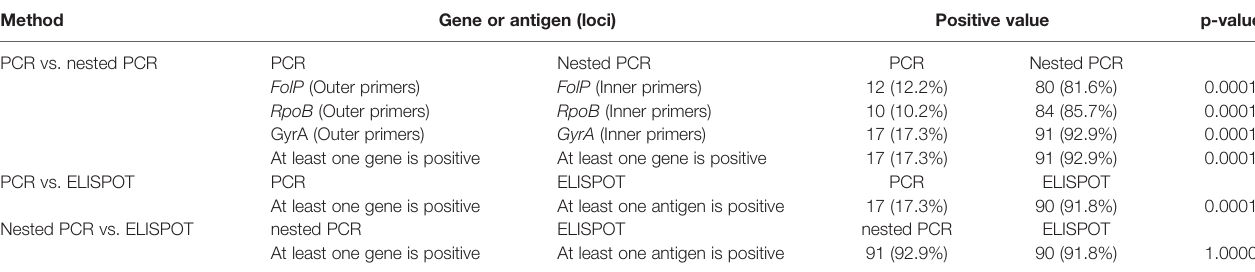
TABLE 4 | Comparison of the results of molecular and ELISPOT assays using clinical samples of clinically diagnosed new PB leprosy patients and healthy donor. Method Gene or antigen